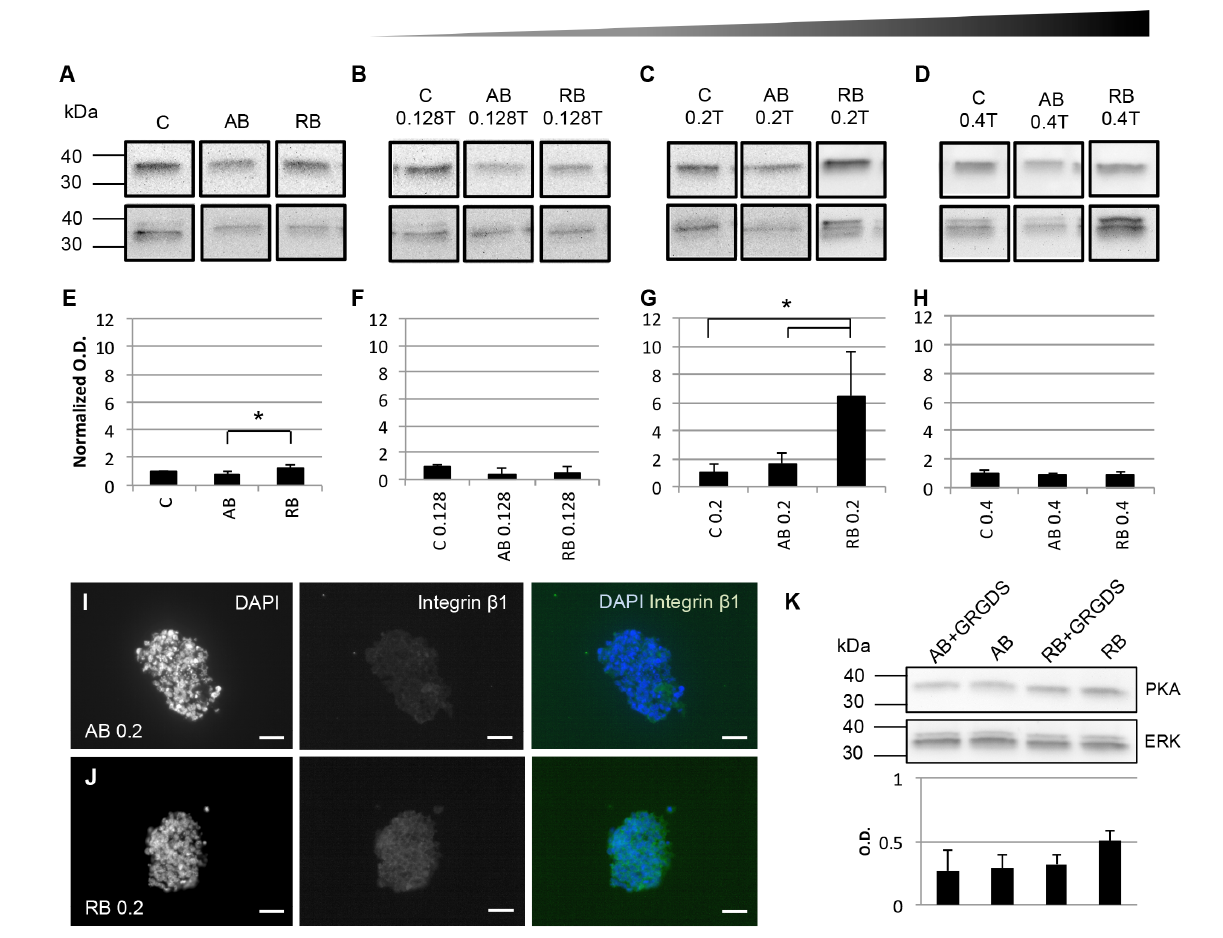
Fig. 4. Second messenger marker expression in response to magnetic attraction. EBs incubated in static conditions (A, E) were compared to EBs exposed to 0.128 Tesla magnetic fields (B, F), 0.2 Tesla magnetic fields (C, G) and 0.4 Tesla magnetic fields (D, H). (A–D) Representative western blots under each condition. Raw western blot data is presented in S2 Figure. (E–H) Normalized PKA expression relative to ERK. (I) b 1 integrin immunostaining in EBs with AcLDL-Beads and (J) RGD-Beads 24 hours following stimulation at 0.2 Tesla. Scale 5 20 m m. (K) Effect of b 1 integrin inhibition by GRGDS on PKA expression. C: control, AB: AcLDL-Beads, RB: RGD-Beads. * p , 0.05.